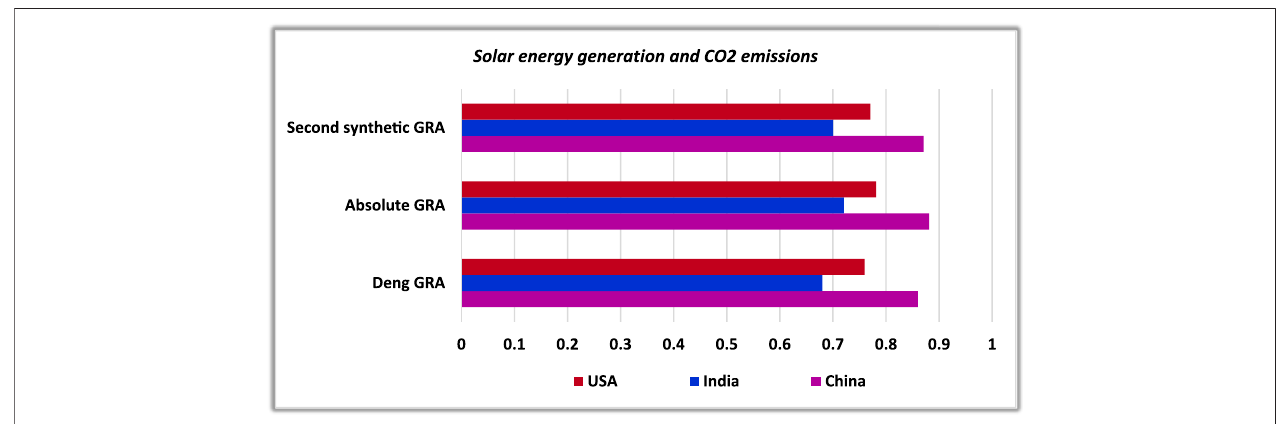
FIGURE 7 | Grey relational assessment between solar energy generation and CO 2 emissions.